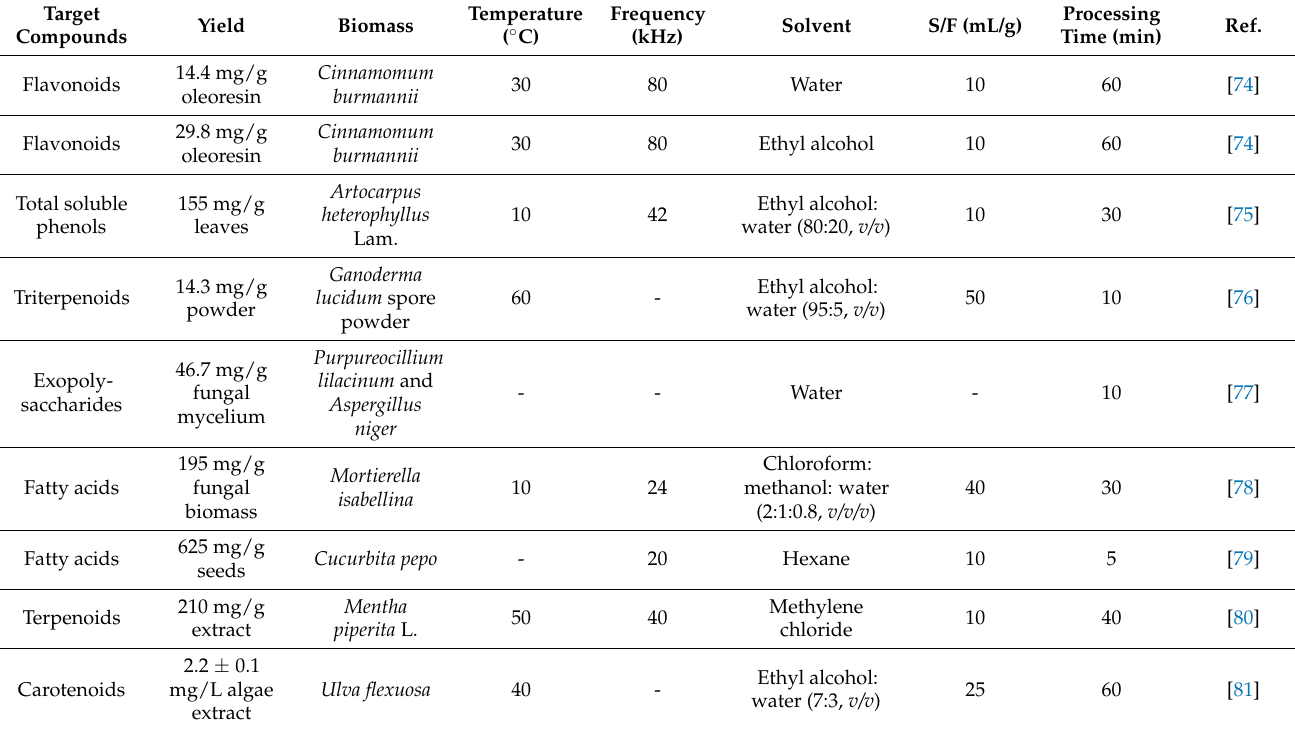
Table 1. Extraction of selected target compounds from different biomasses using ultrasound as a single operation. Target